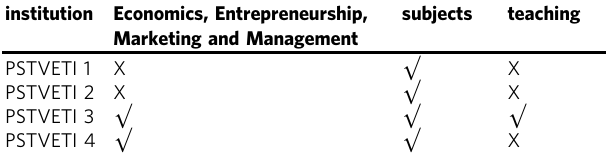
Table 7 Curriculum of TVET schools. TVET Accounting, Customer Care, institution Economics, Entrepreneurship, Marketing and